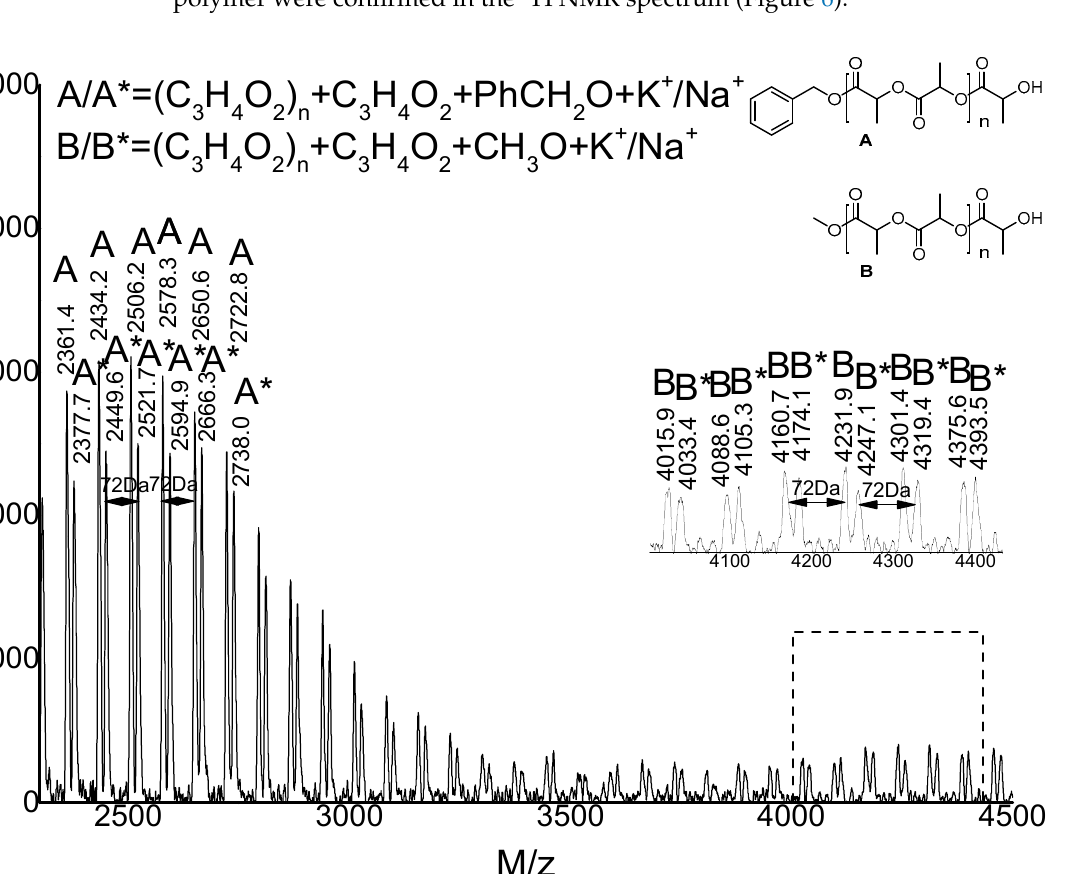
Figure 6. MALDI-TOF spectrum of PLLA prepared by K2 and 10 equivalent BnOH (run 9, Table 2).